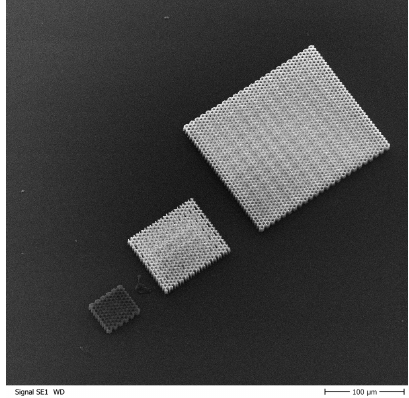
Figure 16. Quantity scale: hex structure